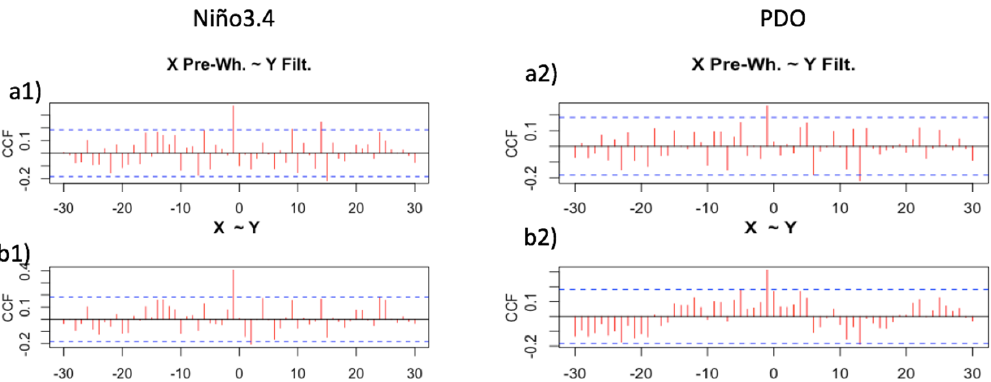
Figure 9. ( a1 ) Sample cross-correlation function (CCF) between the pre-whitened Pacific Decadal Oscillation (PDO) series denoted as X and the filtered PDSI series denoted as Y for the training period; ( a2 ) the sample CCF between the PDO series and the PDSI series; ( b1 ) CCF pre-whitened Niño3.4 and the filtered PDSI; ( b2 ) the sample CCF between the Niño3.4 series and the PDSI series.